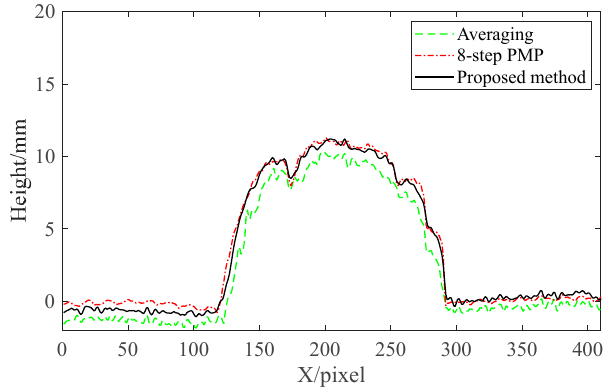
Figure 9. The 255th column data of the reconstructed object.